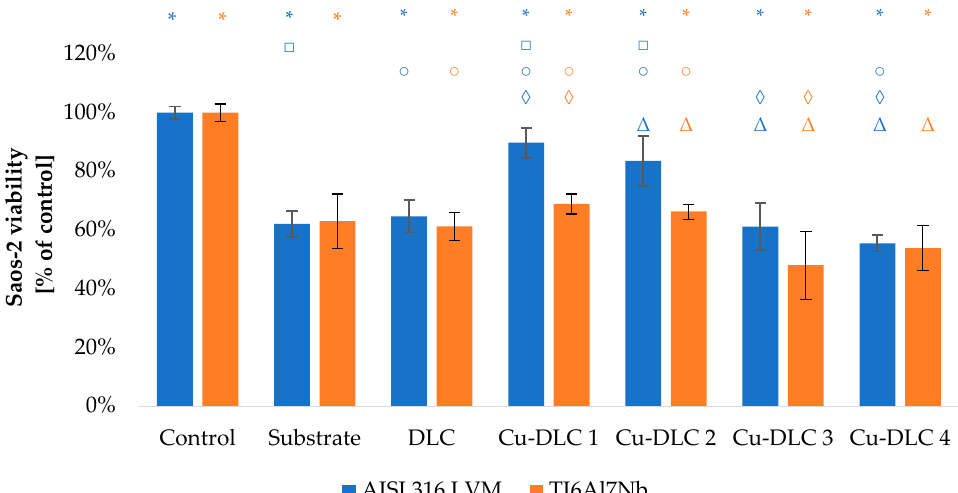
Figure 15. Evaluation of viability of Saos-2 cell on the surface of Ag-DLC coatings deposited on AISI 316LVM and Ti6Al7Nb (live/dead test). Total number of cells expressed as a percentage of control.